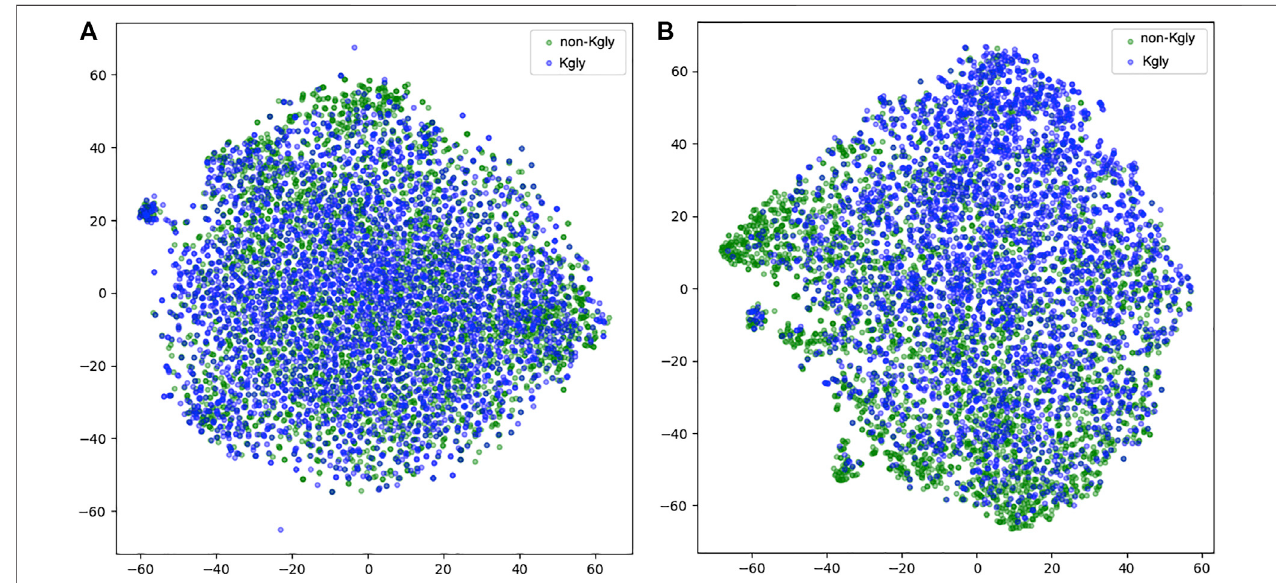
FIGURE 5 | t -SNE illustration of the embeddings extracted from BERT and the features transformed by 1D CNN. (A) Embeddings extracted from BERT-prot. (B) Features transformed by 1D